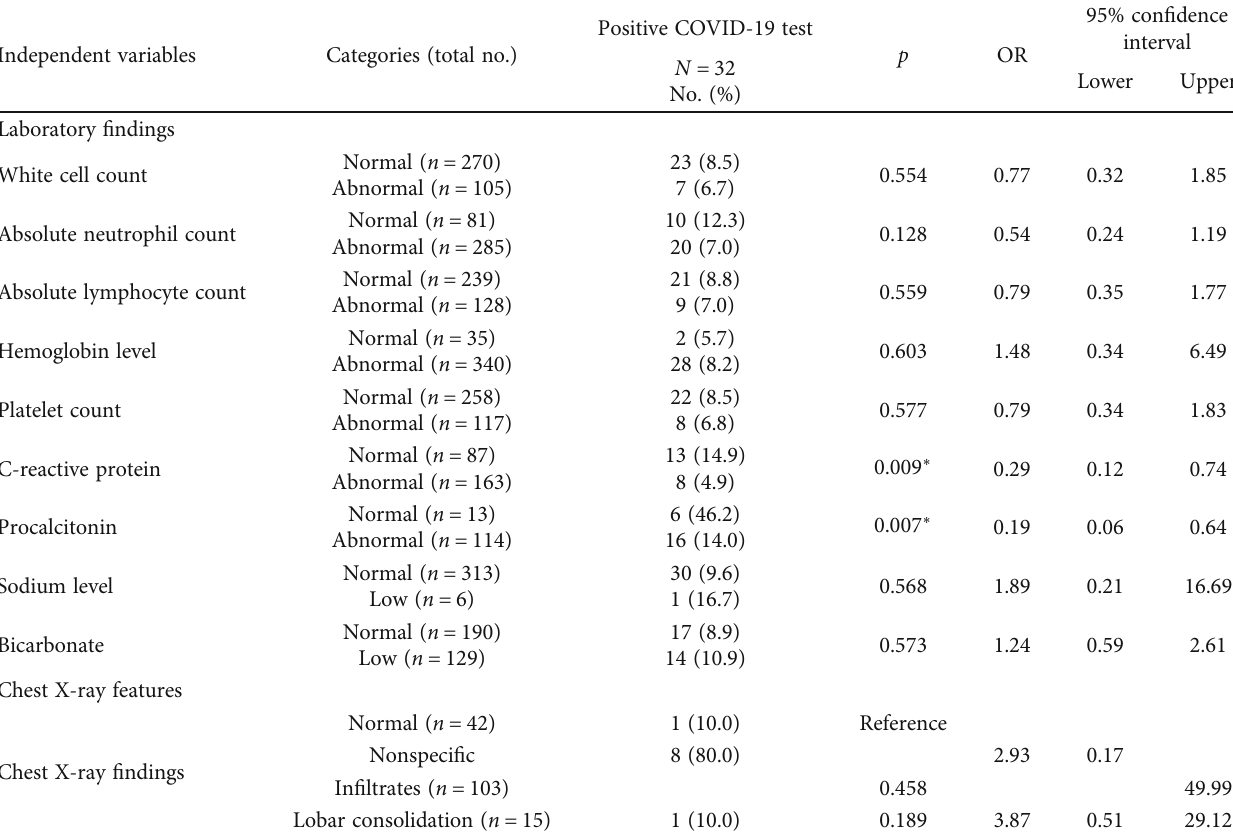
Table 2: Univariate logistic regression analysis of the associated factors (laboratory parameters and chest X-ray features) of positive COVID-19 test.